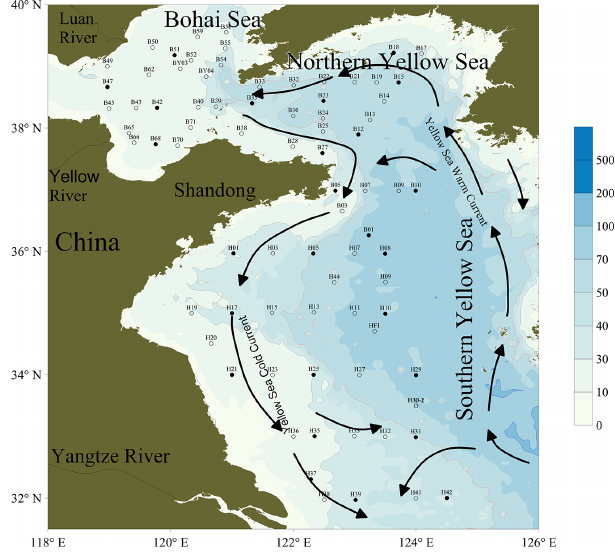
Figure 1. Locations of the sampling stations in the BS and the YS during summer. Solid dots ( • ) represent the stations for incubation